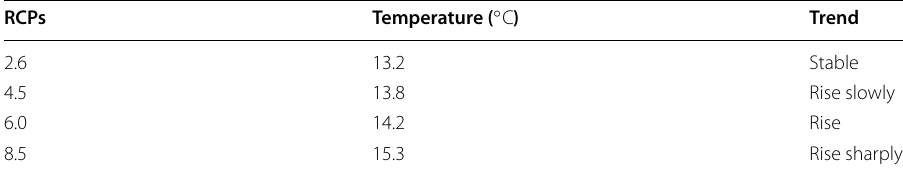
Table 1 Prediction result in 2017 under different RCPs RCPs Temperature ( ◦ C )